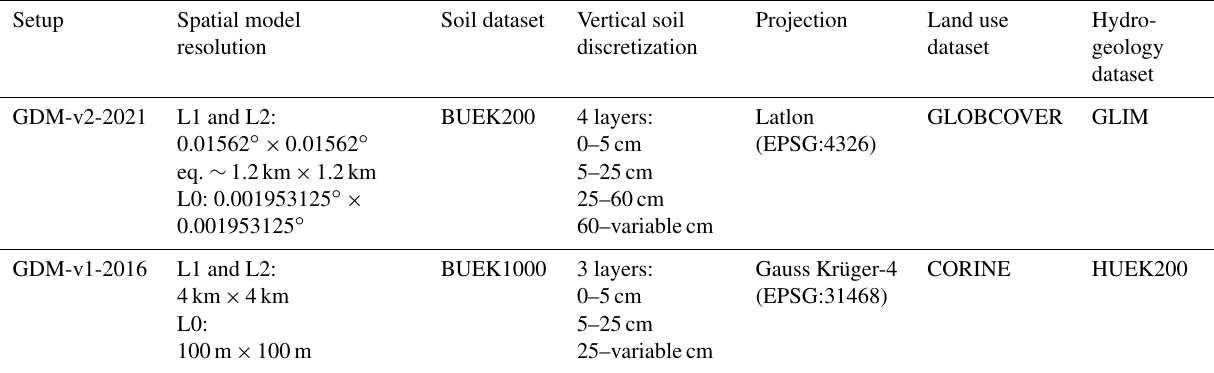
Table 1. Main features of the model setups GDM-v1-2016 and GDM-v2-2021. Core to the setups is the mesoscale hydrological model mHM. Vertical discretization of soil layers in the hydrological model mHM and projection system are denoted. In the spatial model resolution, the Level 0 (L0) describes the subgrid variability of relevant basin characteristics. Level 1 (L1) and Level 2 (L2) describe the dominant hydrological processes and meteorological forcings, respectively. Datasets used as model inputs for soil as well as land use and geology on L0 model resolution are stated. Spatial model Soil dataset Vertical soil Projection Land use Hydro- resolution discretization dataset geology